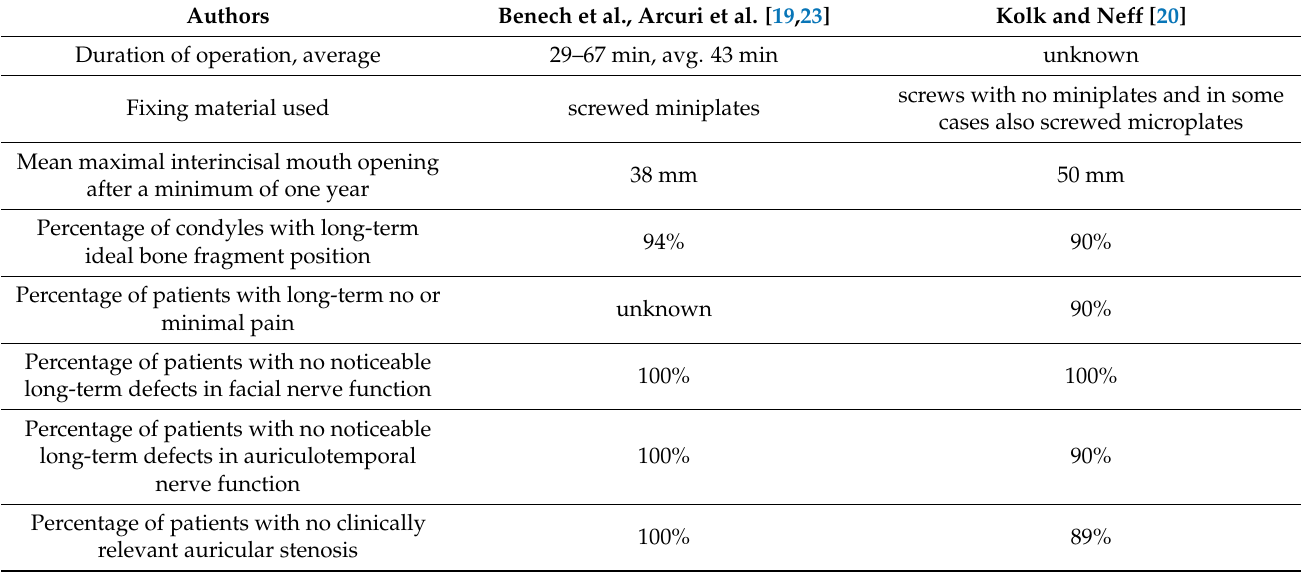
Table 3. Results of the analyzed